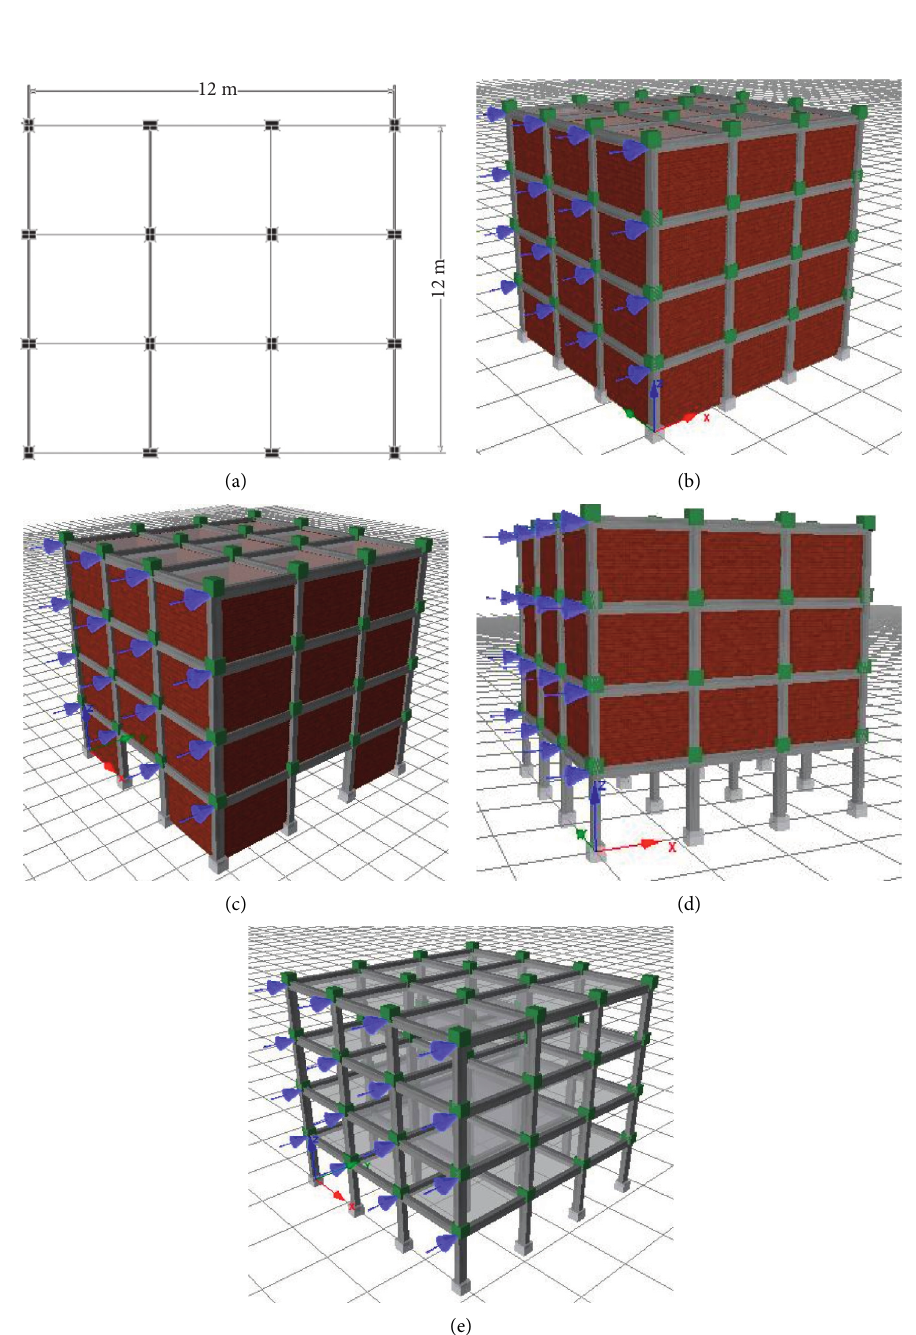
Figure 4: Structural models in this study: (a) plan of the building; (b) Model I; (c) Model II; (d) Model III; (e) Model